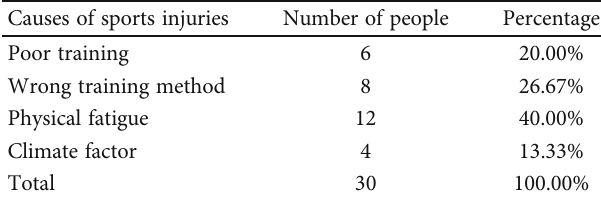
Table 1: Causes of athletic injuries in